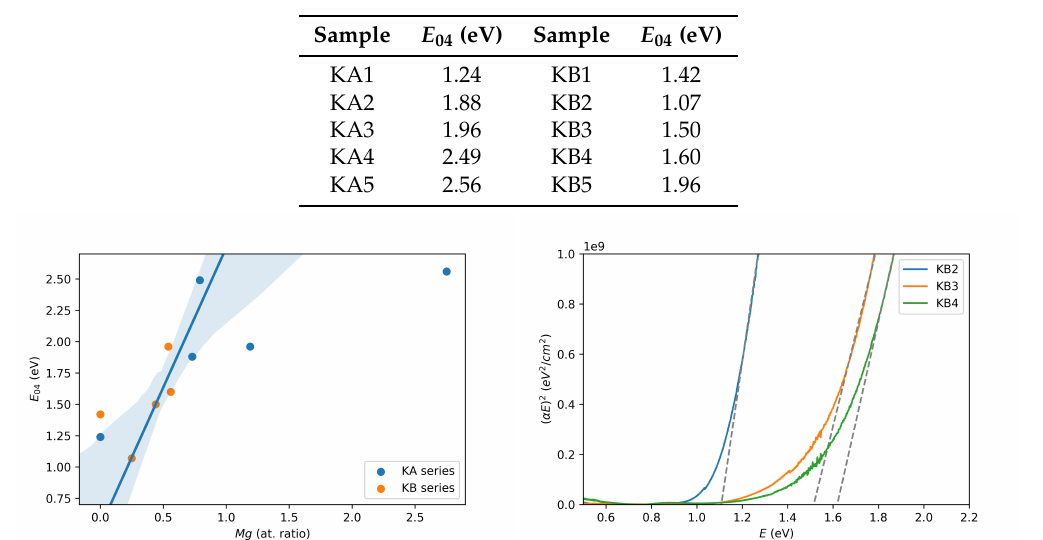
Table 3. E 04 values for all samples.